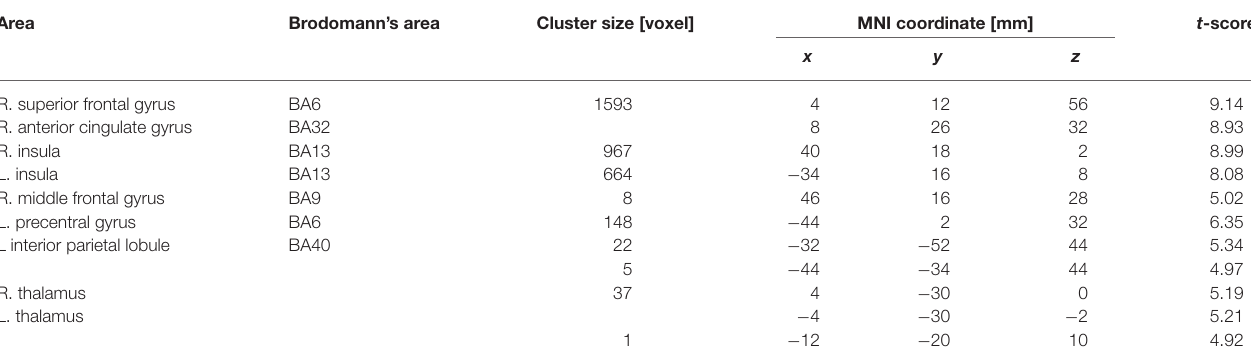
TABLE 3 | Cortical areas showing significant activation reflecting recognition of own mistake which was represented by comparison between conditions that failure feedback has been received vs. success feedback has been received in current trial. Area